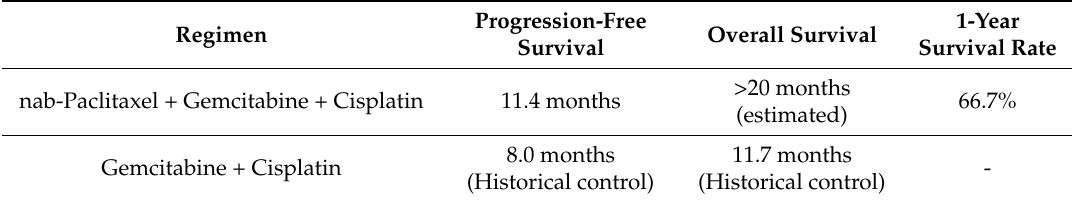
Table 10. Results of a phase II clinical trial to investigate nab-paclitaxel in combination with gemcitabine and cisplatin in advanced biliary tract